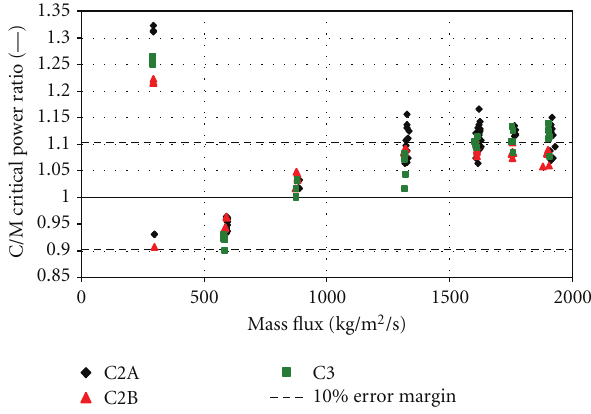
Figure 8: Comparison of predicted and measured void fraction results at 2.730 m.